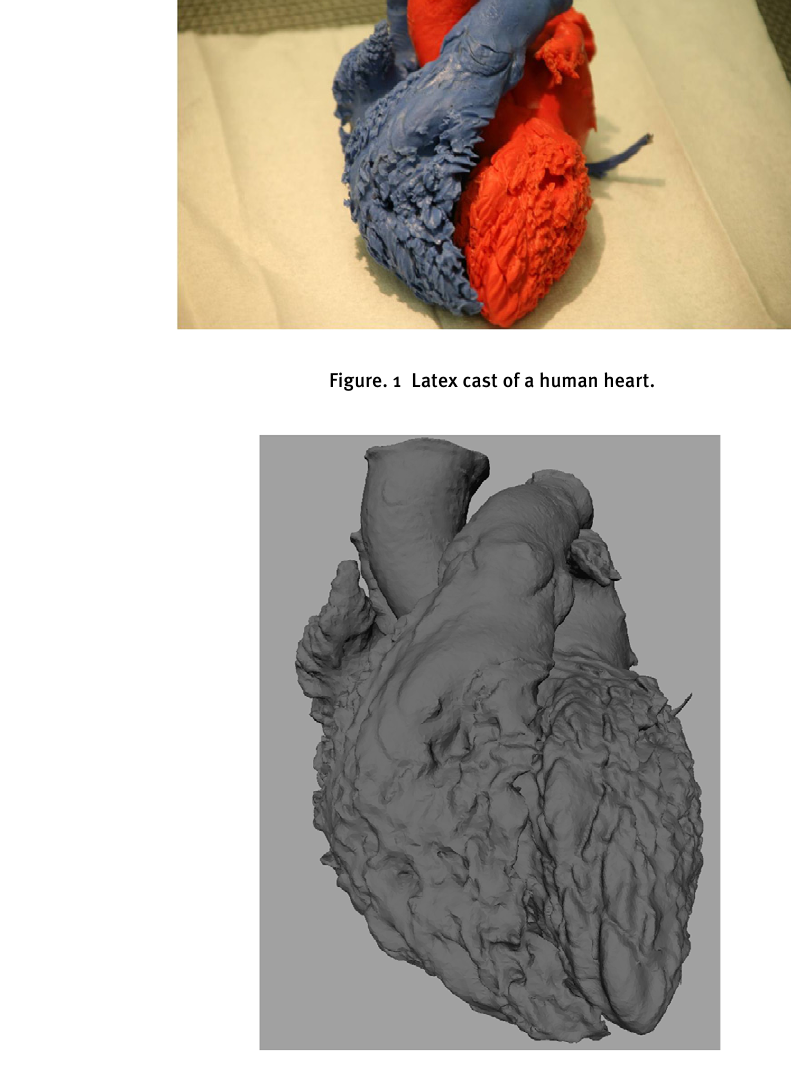
Figure. 2 3D scan of latex